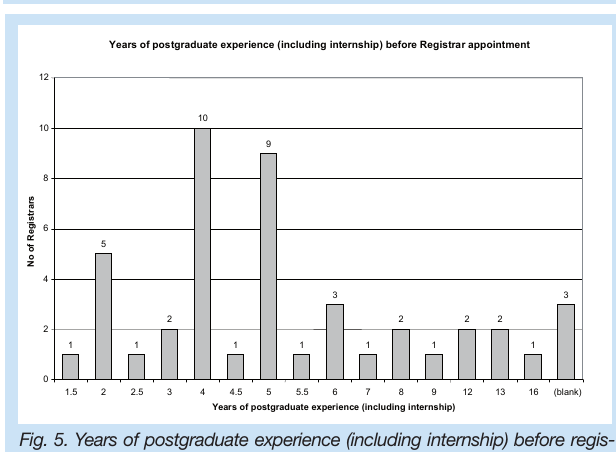
Fig.1.Registrarsattendingthecollegecourseaccordingtoage. Fig. 1. Registrars attending the college course according to age.